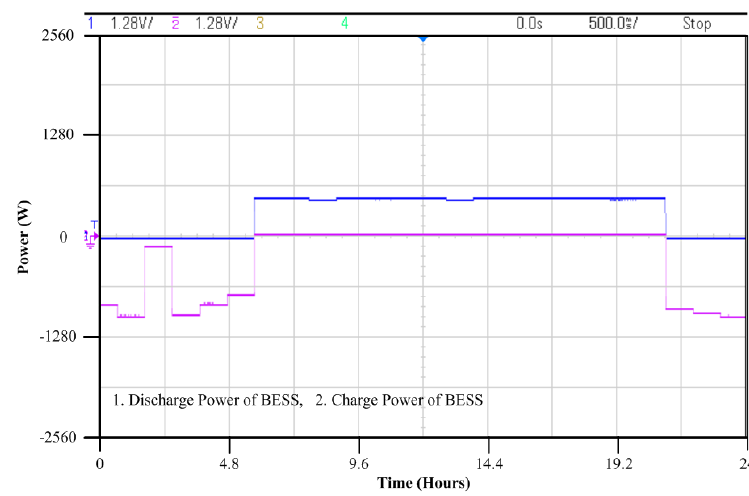
Figure 15. Grid power for scenario-2.